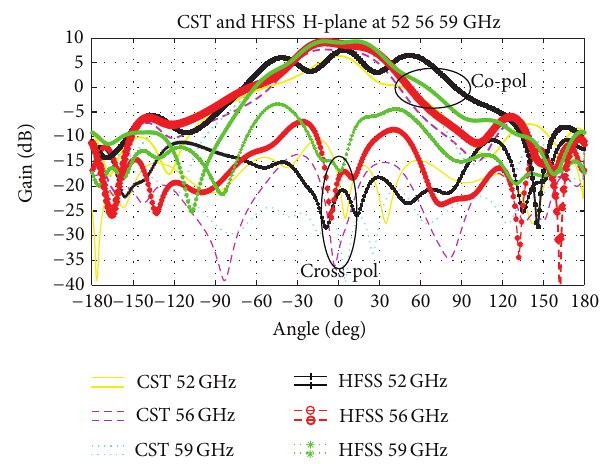
Figure 5: H-plane radiation